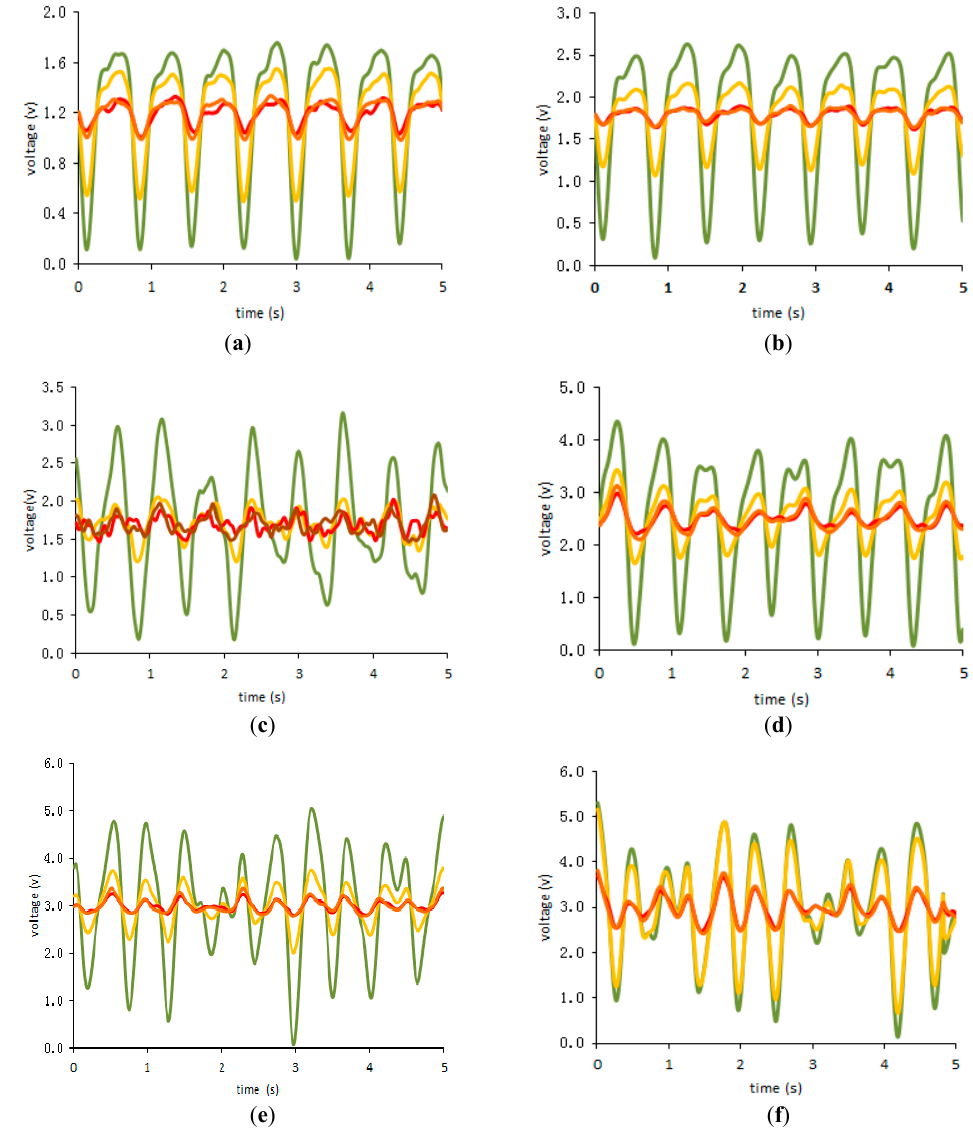
Figure 10. ( a ) resting without auto adaption; ( b ) resting with auto adaption; ( c ) walking without auto adaption (3 km/h); ( d ) walking with auto adaption (3 km/h); ( e ) jogging without auto adaption (6 km/h); ( f ) jogging with auto adaption (6 km/h). The green line stands for the response from the green LED illumination; the orange line stands for yellow LED illumination; the red line stands for red LED illumination; the brown line stands for the peak value illumination.